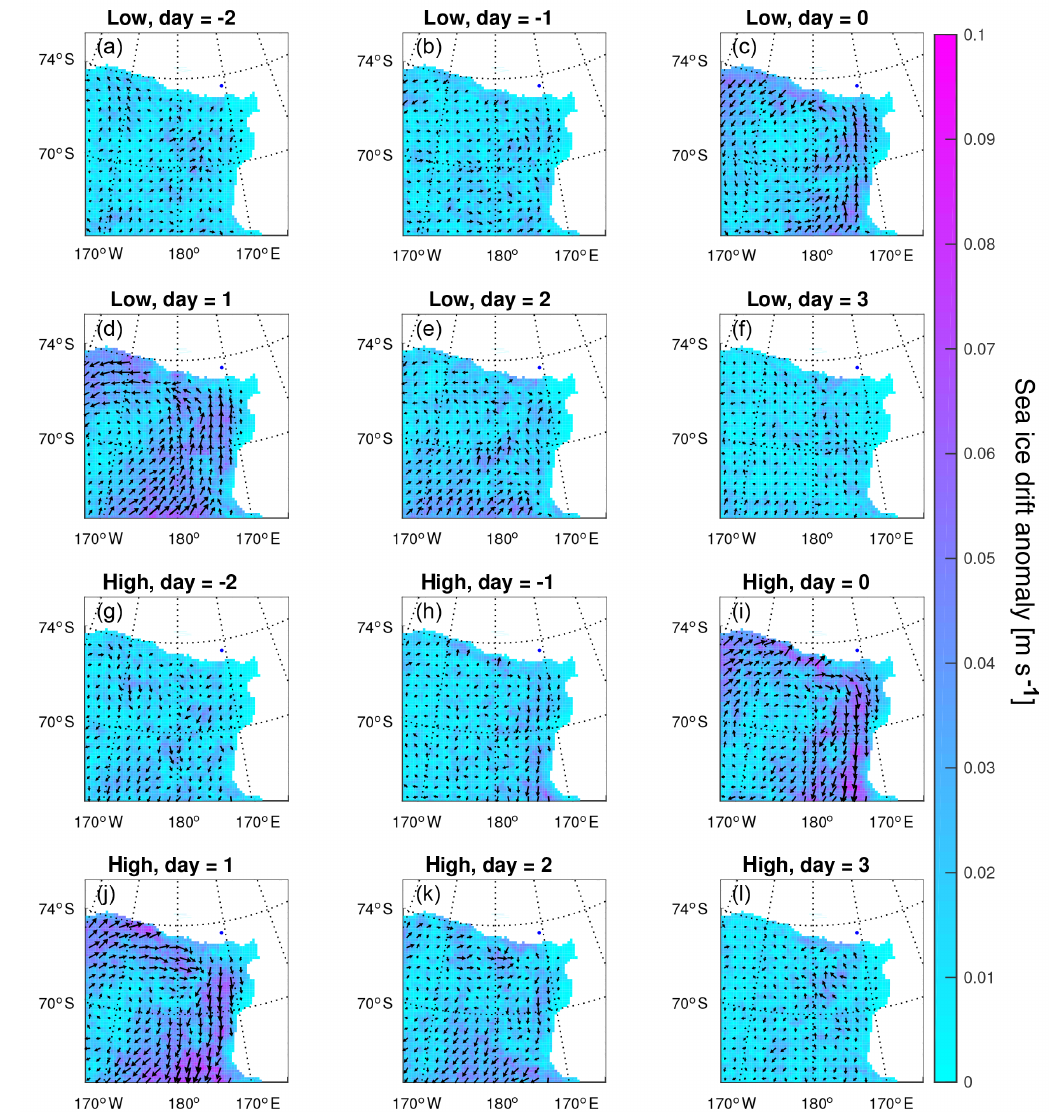
Figure 8. (a–f) Sea ice motion anomalies for days − 2 to 3 for low-wind events. (g–l) Sea ice motion anomalies for days − 2 to 3 for high-wind events. Composites are formed over the 2000–2014